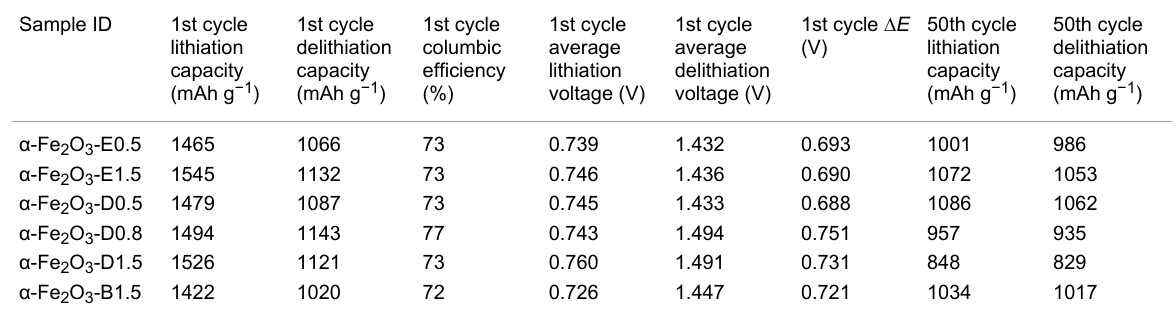
Table 2: Electrochemical data of α -Fe 2 O 3 synthesized with different SCAs and various Fe 3+ concentrations. Sample